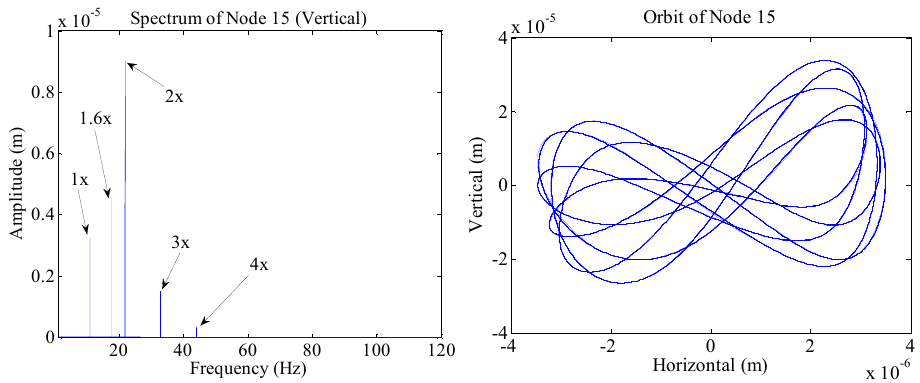
Figure 8. The spectrum and the orbit of Bearing 3 (misalignment at Bearing 1).